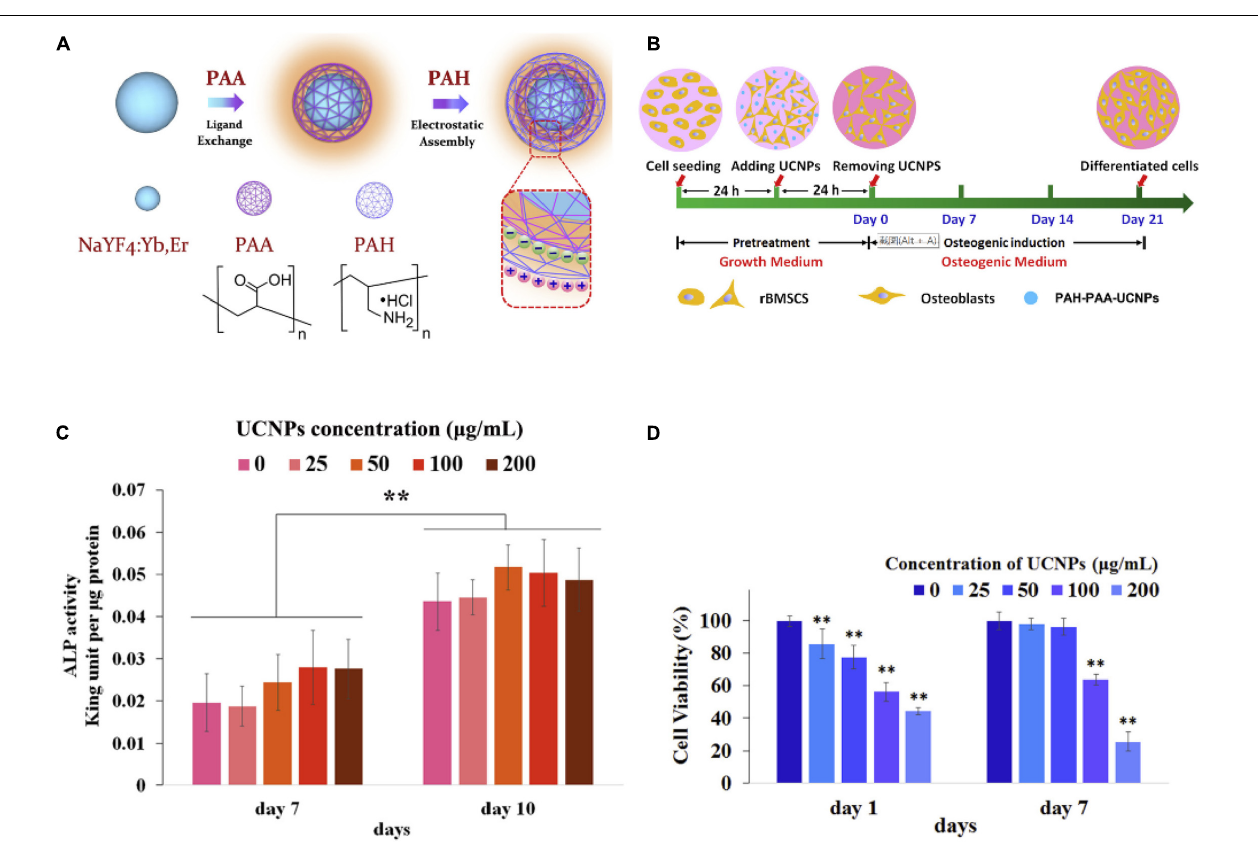
FIGURE 5 | (A) Upconversion (UC)-based NPs synthesis. (B) Cell pretreatment and osteogenic differentiation process. (C) Normalized alkaline phosphatase activity expression by MSCs. (D) Cell viability (adapted by Ma et al., 2016). ∗∗ p < 0.01 compared with control